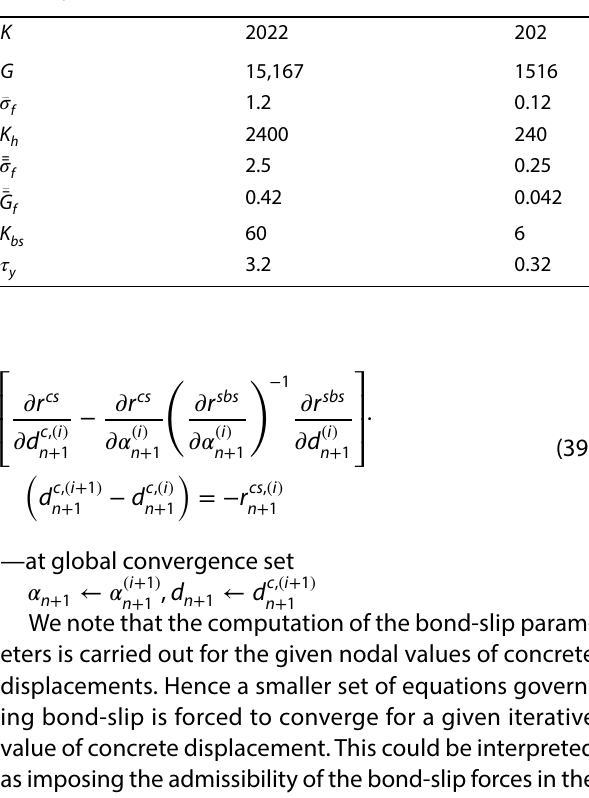
Fig. 19 RC composite testing of crack spacing and opening: a experimental set-up of a tie-beam test; b experimental measure- ments of crack spacing and opening for a series of tie-beam speci- mens; c computational results for stress distribution along the bar in concrete, steel and bond; d computational results for plastic bond-slip along the bar